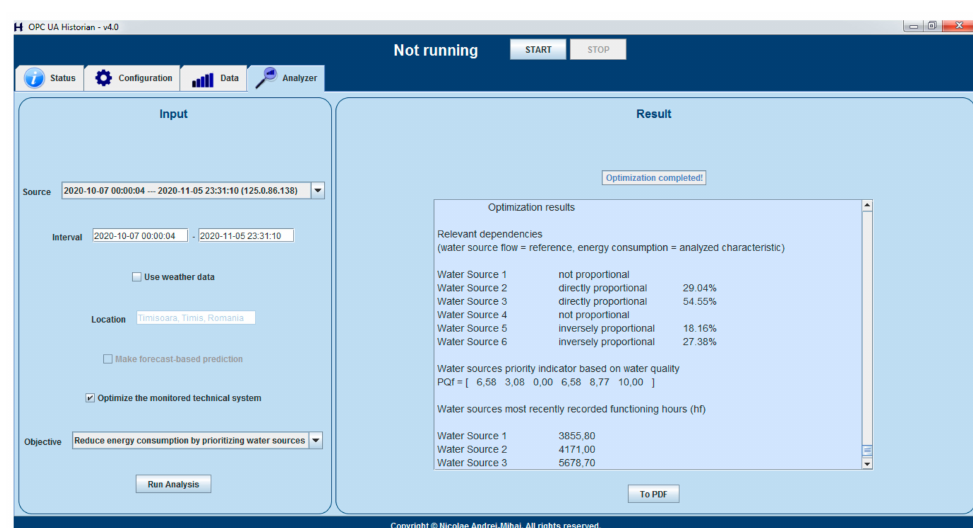
Figure 8. Example of displaying, in the Historian GUI, the results of running the optimization